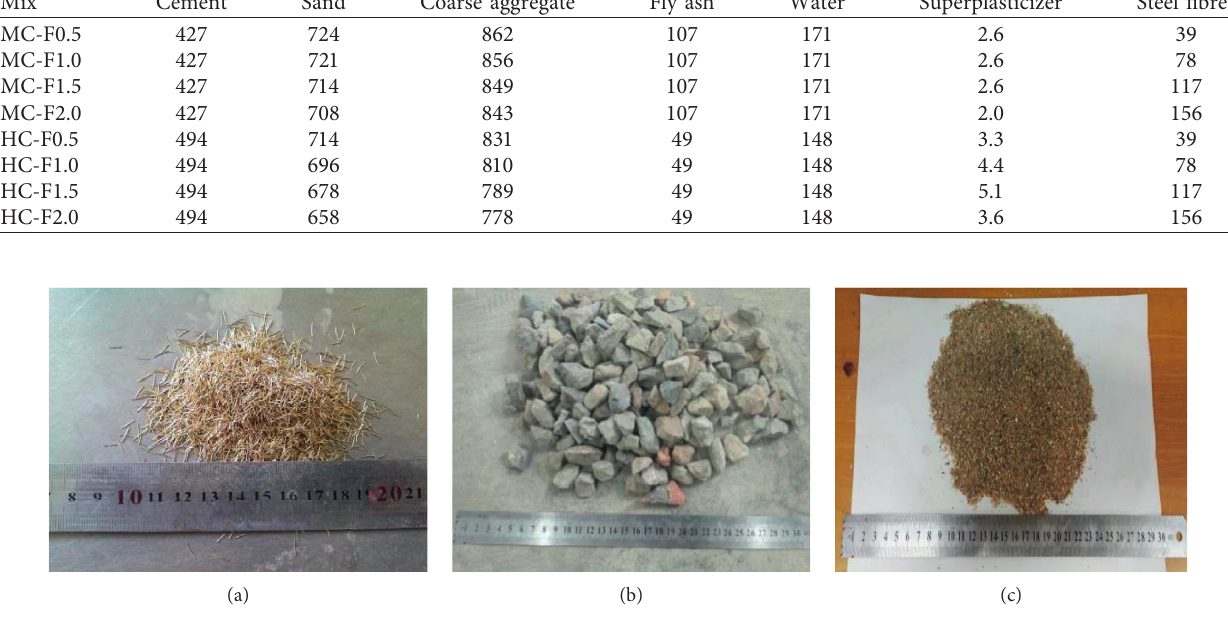
Figure 1: Materials used in this study: (a) steel fibres; (b) coarse aggregate; (c) sand.